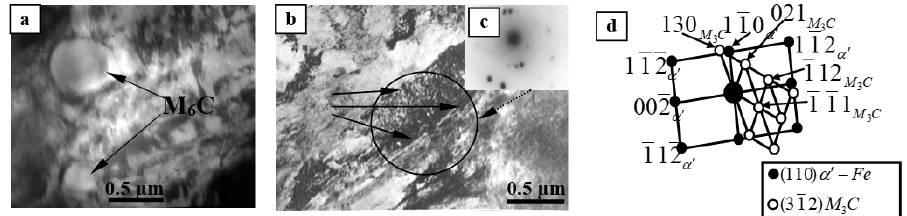
Figure 3. TEM images of the fine structure of R6M5 steel with identified carbides ( a )—the bright-field image of M 6 C type carbide particles; ( b )—the bright-field image, ( c , d )—the microdiffraction pattern and its indicated pattern.